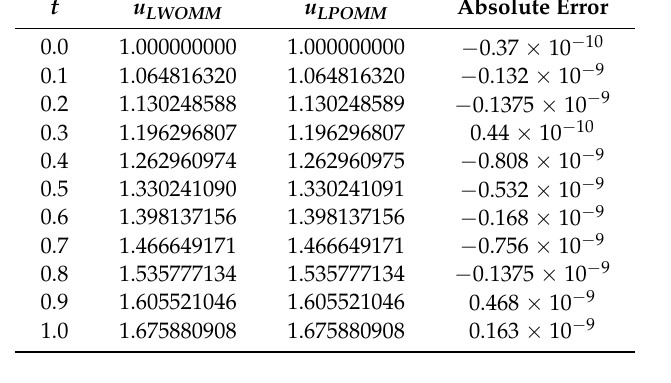
Table 5. Our solutions u ( t ) when attained by the presented method and the LPOMM for Example 3.